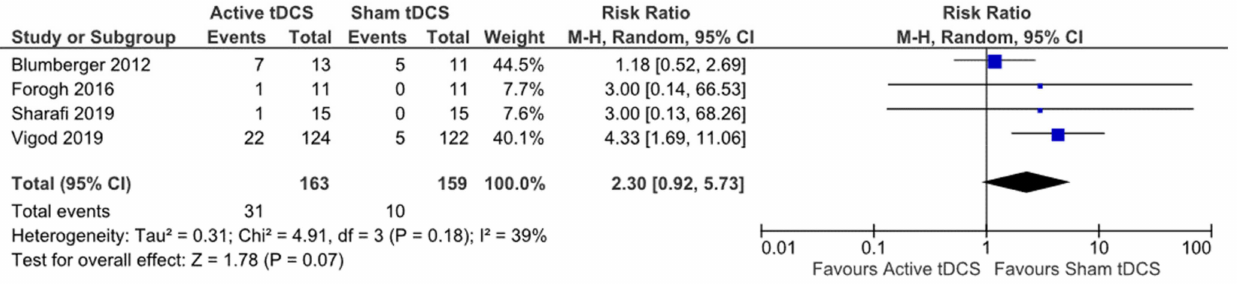
Figure 9. Forest plot adverse